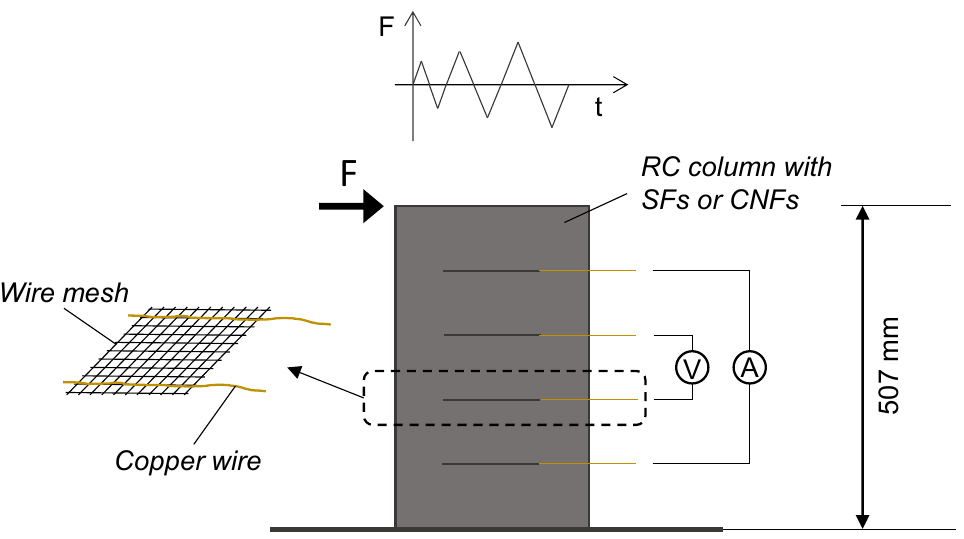
Figure 5. Resistivity measurement layout for RC shear-critical columns (adapted from [76]).